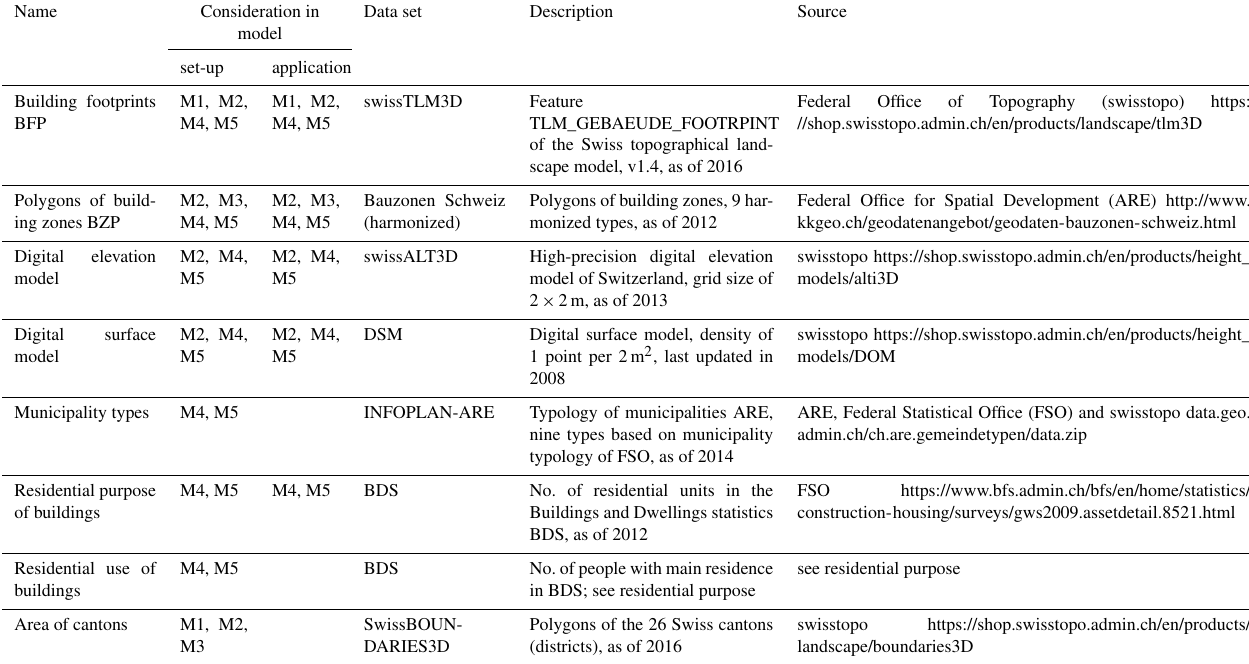
Figure A1. Diagnostic plots of model M5, namely residuals vs. fitted values (a) , quantile–quantile plots of residuals vs. normally distributed quantiles (b) , scale location plot (c) and Cook’s distance plot (d) . Table A1. Summary of data used in the set-up and/or application of the five building value models. All links were last checked on 7 Septem- ber